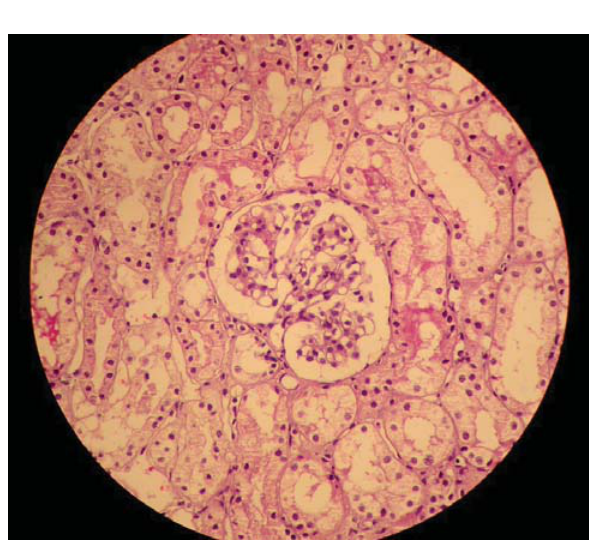
Fig. 6 - Corte histológico renal mostrando estruturas